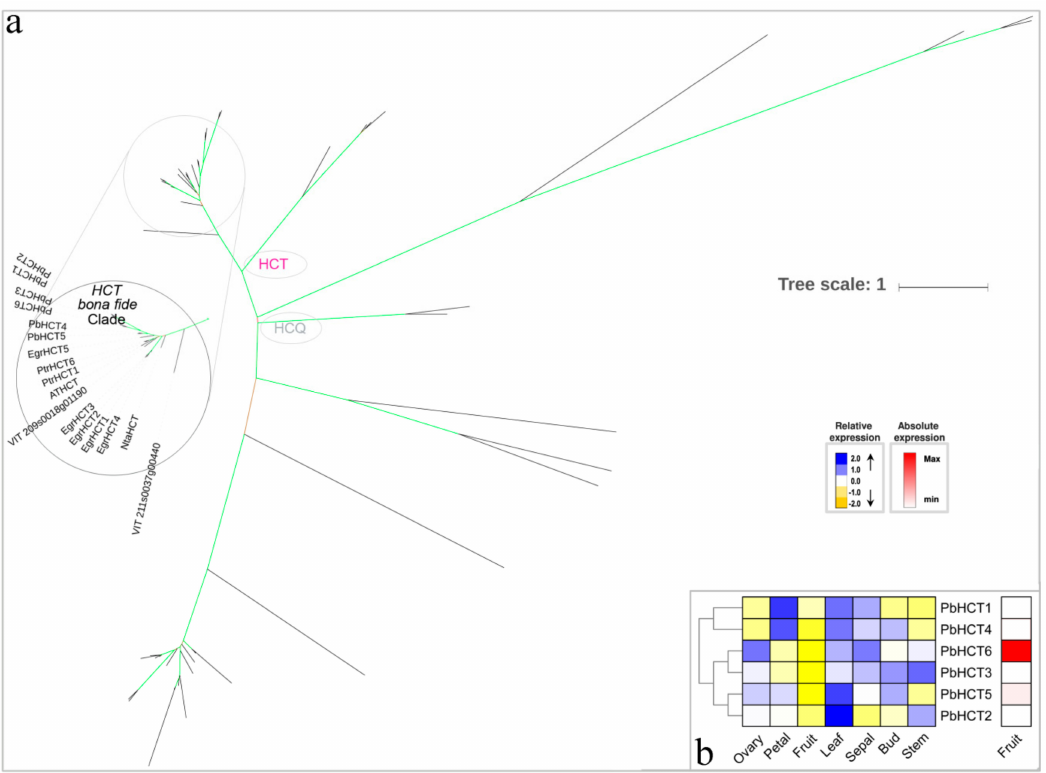
Figure 6. Phylogenetic tree and expression profiles of the HCT bona fide clade. ( a ) ML tree built with HCT bona fide enzymes from several species. ( b ) The expression profiles P. bretschneideri HCT bona fide genes. Subclade containing the bona fide genes is highlighted. The green color of the tree branches suggests strong node support (bootstrap support ≥ 95% and SH-aLRT ≥ 75%). The FPKM values of PbHCT genes in di ff erent tissues are indicated in Table S3. The gene accession number is indicated in Table S4, Figure S2. The tree scale is the number of amino acid substitution per